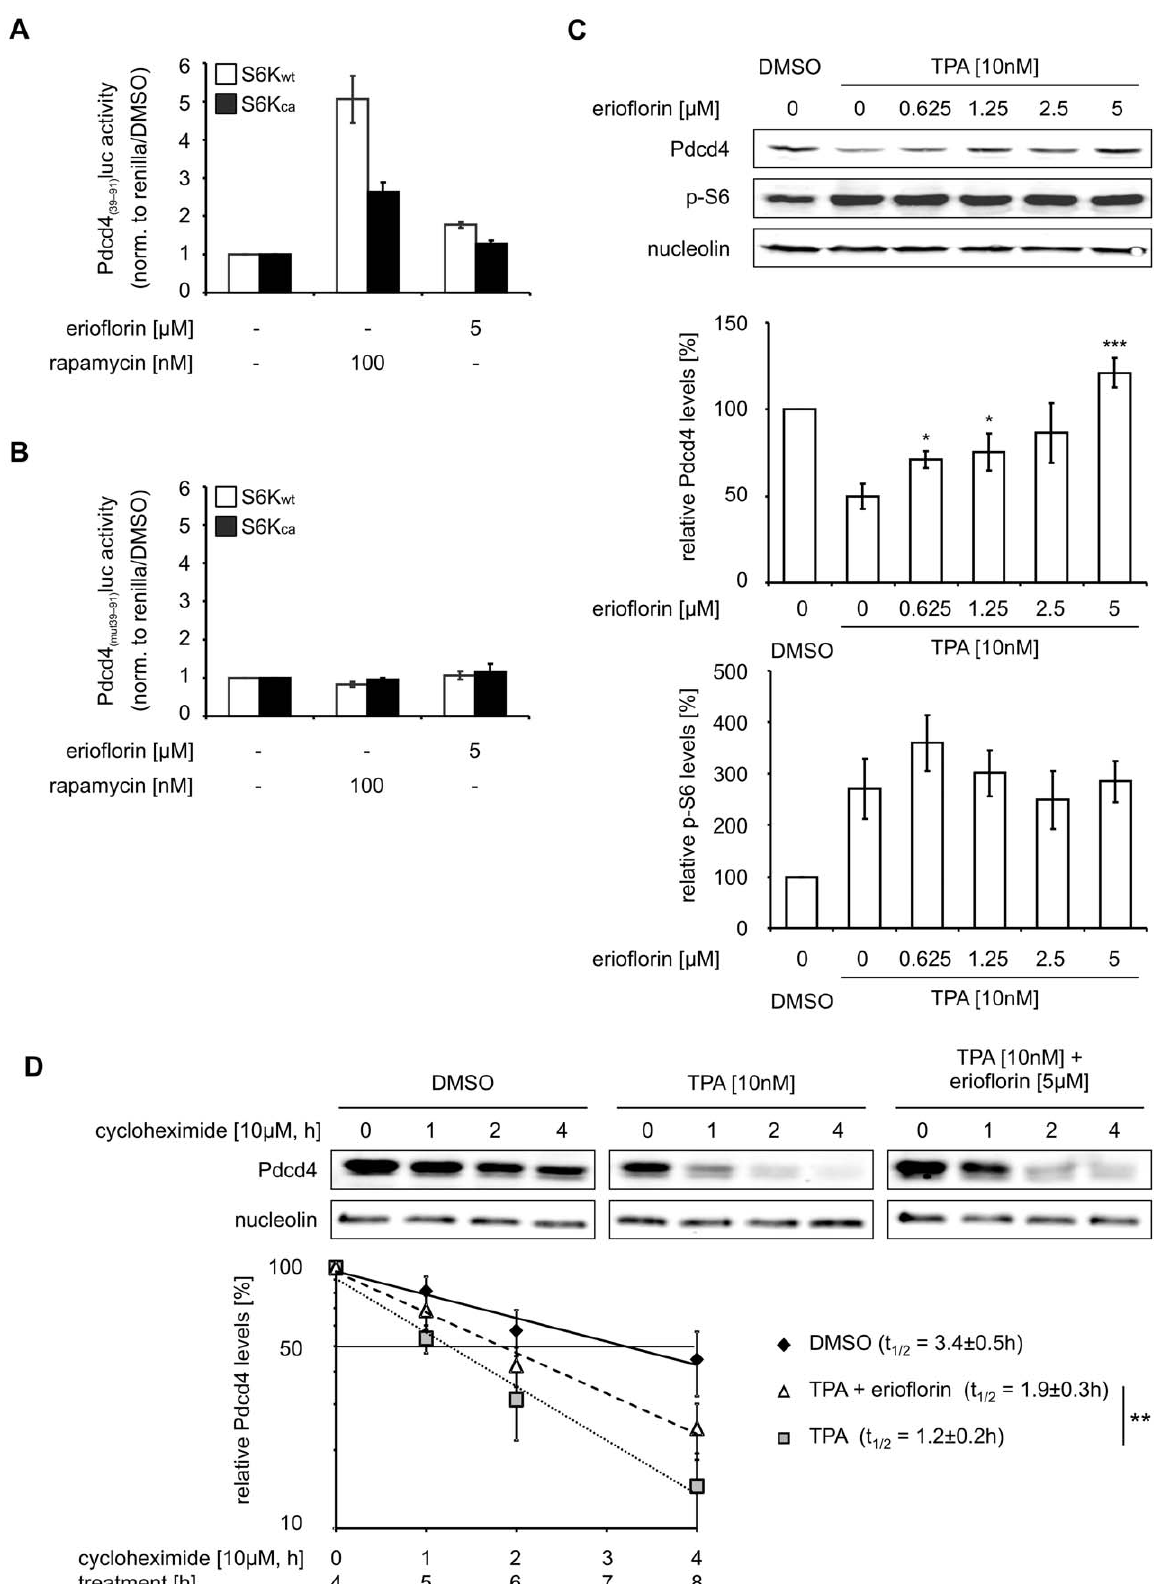
Figure 2. Erioflorin stabilizes Pdcd4 without affecting phosphorylation events. (A + B) HEK293 cells were transiently transfected with Pdcd4 (39–91) luc (A) or Pdcd4 (mut39–91) luc (B) firefly reporter vectors, in combination with expression vectors for either wildtype (S6K wt =white bars) or constitutively active p70 S6K (S6K ca =black bars) and a renilla luciferase vector one day prior to the experiment. Transfected cells were treated for 8 h